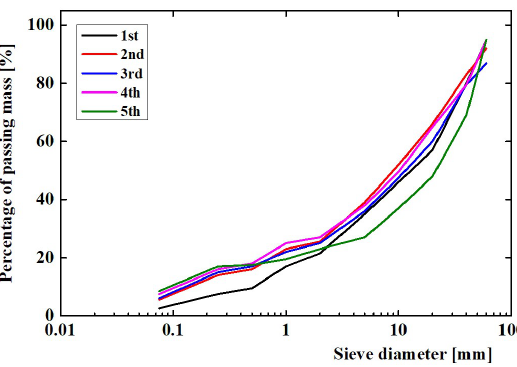
Figure 2. The particle grading curve of filling materials.